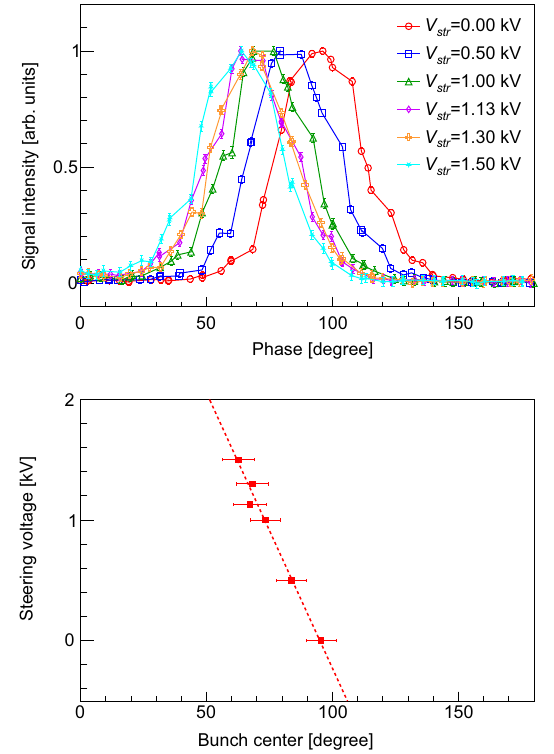
FIG. 22 Shifts of the longitudinal phase distributions with steering voltage (top) and dependence of bunch center on steering voltage (bottom). The red-dotted line in the bottom plot indicates the fitted Þ , was The sensitivity of the voltage to phase, ð ∂ ϕ ∂ V evaluated from the shift of the longitudinal bunch center by scanning the steering voltage. Figure 22 shows the shifts of the longitudinal phase distributions with the steering voltage (top) and the dependence of the bunch center on the steering voltage (bottom). The sensitivity was evalua- ted from the fitted linear function in the bottom plot in Þ ¼ 0 . 022 (cid:2) 0 . 005 degree =V . Therefore, Fig. 22 as ð ∂ ϕ ∂ V from Eq. (A3), the resolution of the BSM was evaluated to be Δ ϕ ¼ 0 . 5 (cid:2) 0 . 2 °.